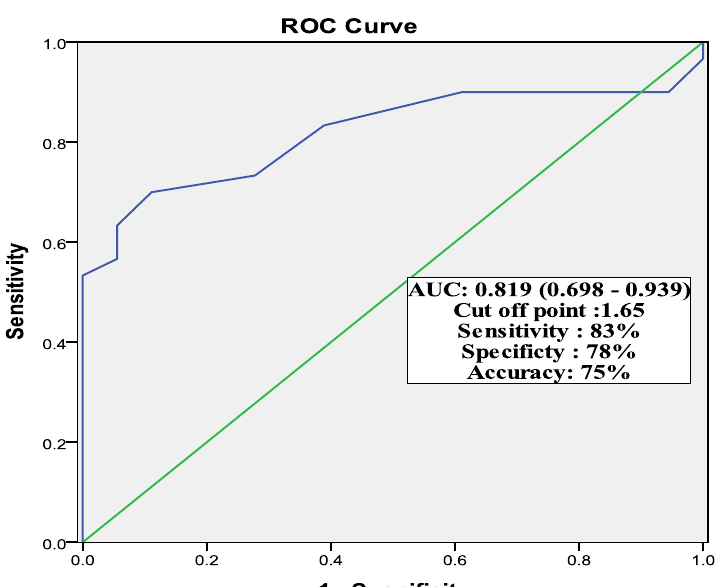
Fig. 6 The sensitivity and specificity of bronchial wall thickness for detection need for mechanical ventilation among inhalation lung injury